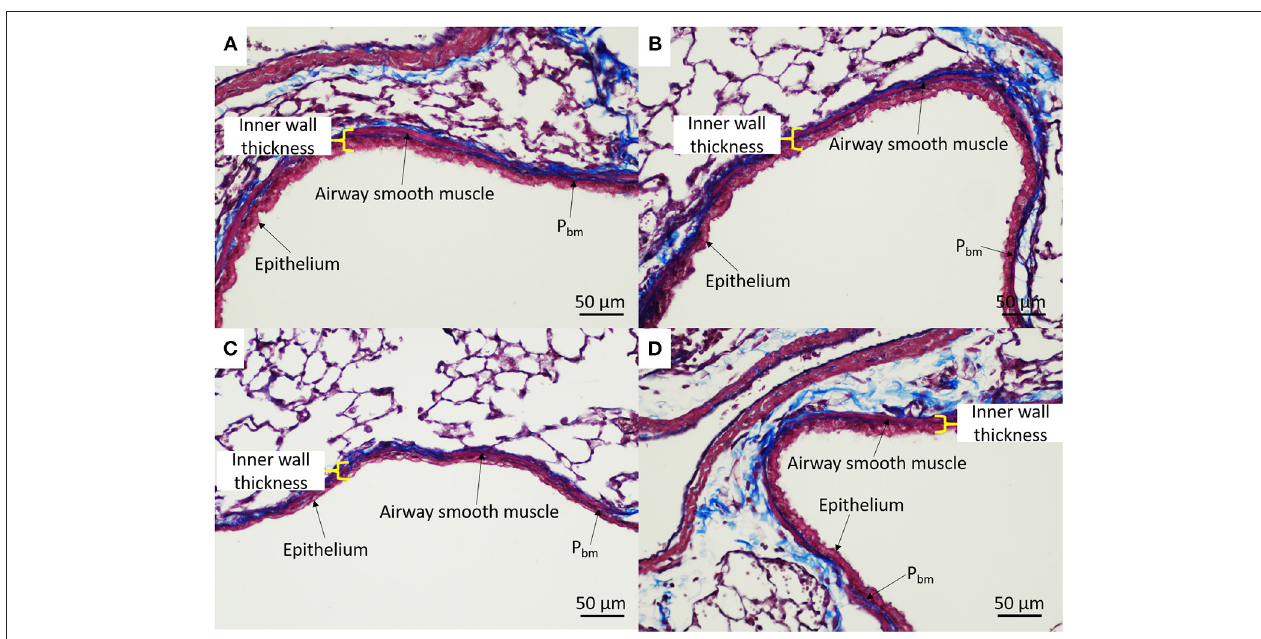
FIGURE 6 | Representative airway histology. IUGR male (A) , IUGR basement membrane. reduced incidence of atopic dermatitis and food allergies